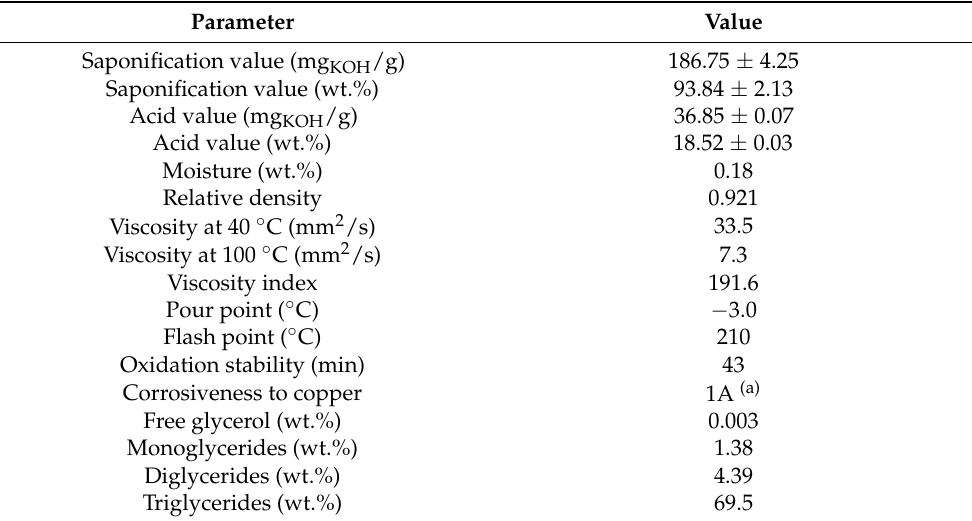
Table 1. Saponifiable composition and physicochemical properties of soybean oil deodorizer distillate (SODD) from Cocamar (Maring á , PR, Brazil), collected in June 2019.